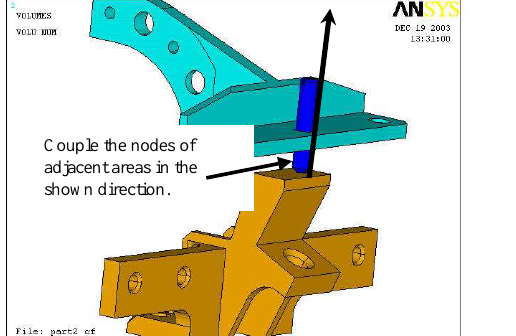
Fig. 9. Coupling between Two Brackets.